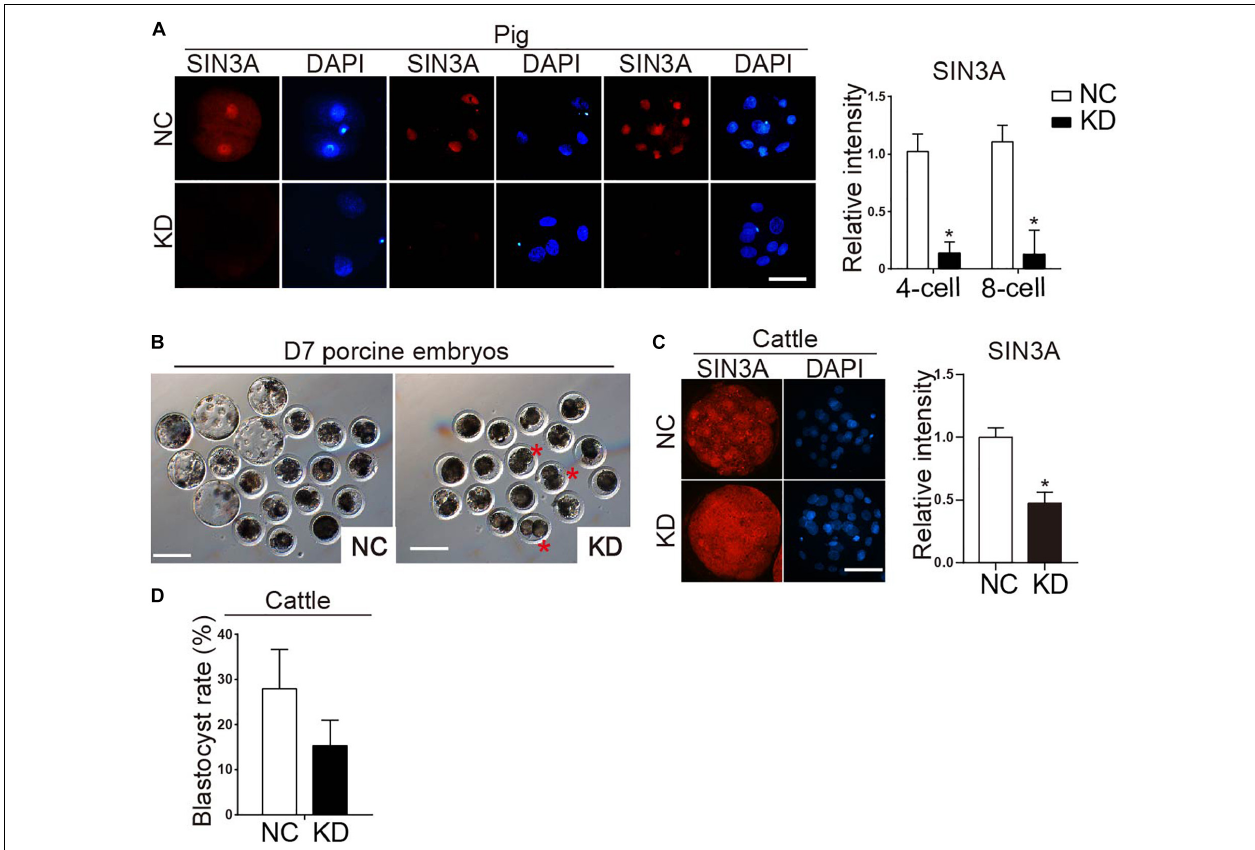
FIGURE 3 | Effect of SIN3A knockdown on the developmental efficiency of porcine parthenogenetic and bovine in vitro fertilized embryos. (A) Immunofluorescence analysis of SIN3A knockdown efficiency in porcine two-, four-, and eight-cell embryos (left). NC represents the embryos injected with negative control siRNA, and KD represents the embryos injected with SIN3A-specific siRNAs. Three independent replicates were performed with 5–10 embryos/group/replicate analyzed. SIN3A (red), nuclei (blue). Scale bar = 50 µ M. Average value of the signal intensities of SIN3A was assessed by densitometry (right). Data are expressed as mean ± SEM. * P < 0.05. (B) Representative pictures of NC and KD porcine embryos after in vitro culture for 7 days. Asterisk indicates abnormal embryos which appeared blocked at two- to four-cell stage in KD group. (C) Detection of knockdown efficacy of bovine SIN3A-specific siRNA at the morula stage. Three independent replicates were performed with six- to eight-cell embryos/group/replicate analyzed. Average value of the signal intensities of SIN3A was assessed by densitometry (right). (D) Blastocyst formation rate of bovine embryos after SIN3A KD. The rate of blastocysts at day 7 was recorded with no significant difference found between the NC and KD groups. Four independent replicates, all data were presented as mean ± SEM.